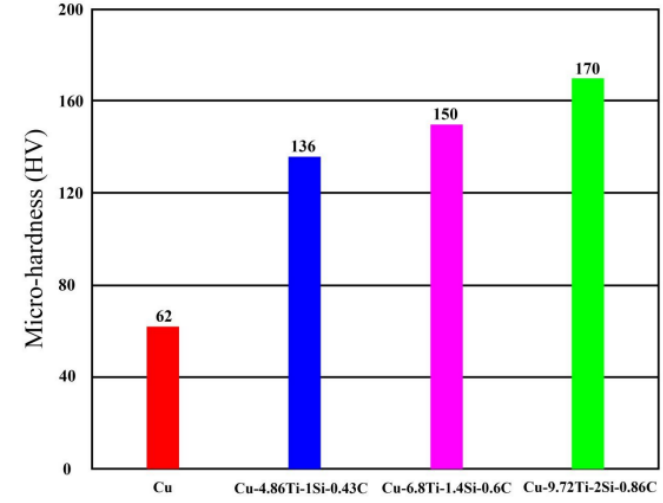
Figure 9. The hardness of the